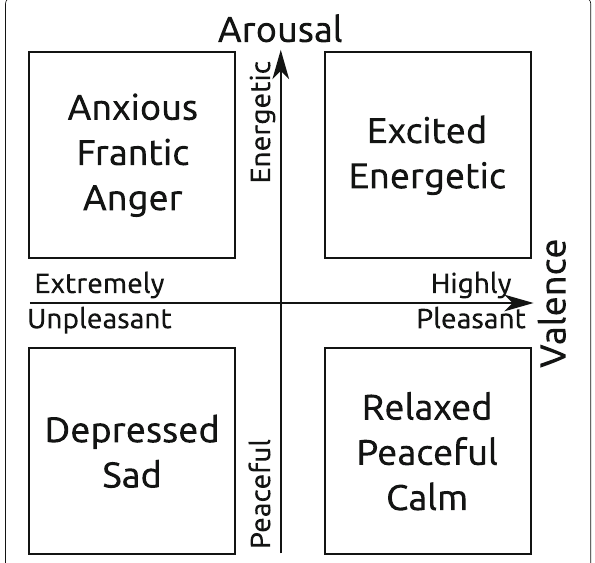
Fig. 5 The two-dimensional space of arousal-valence